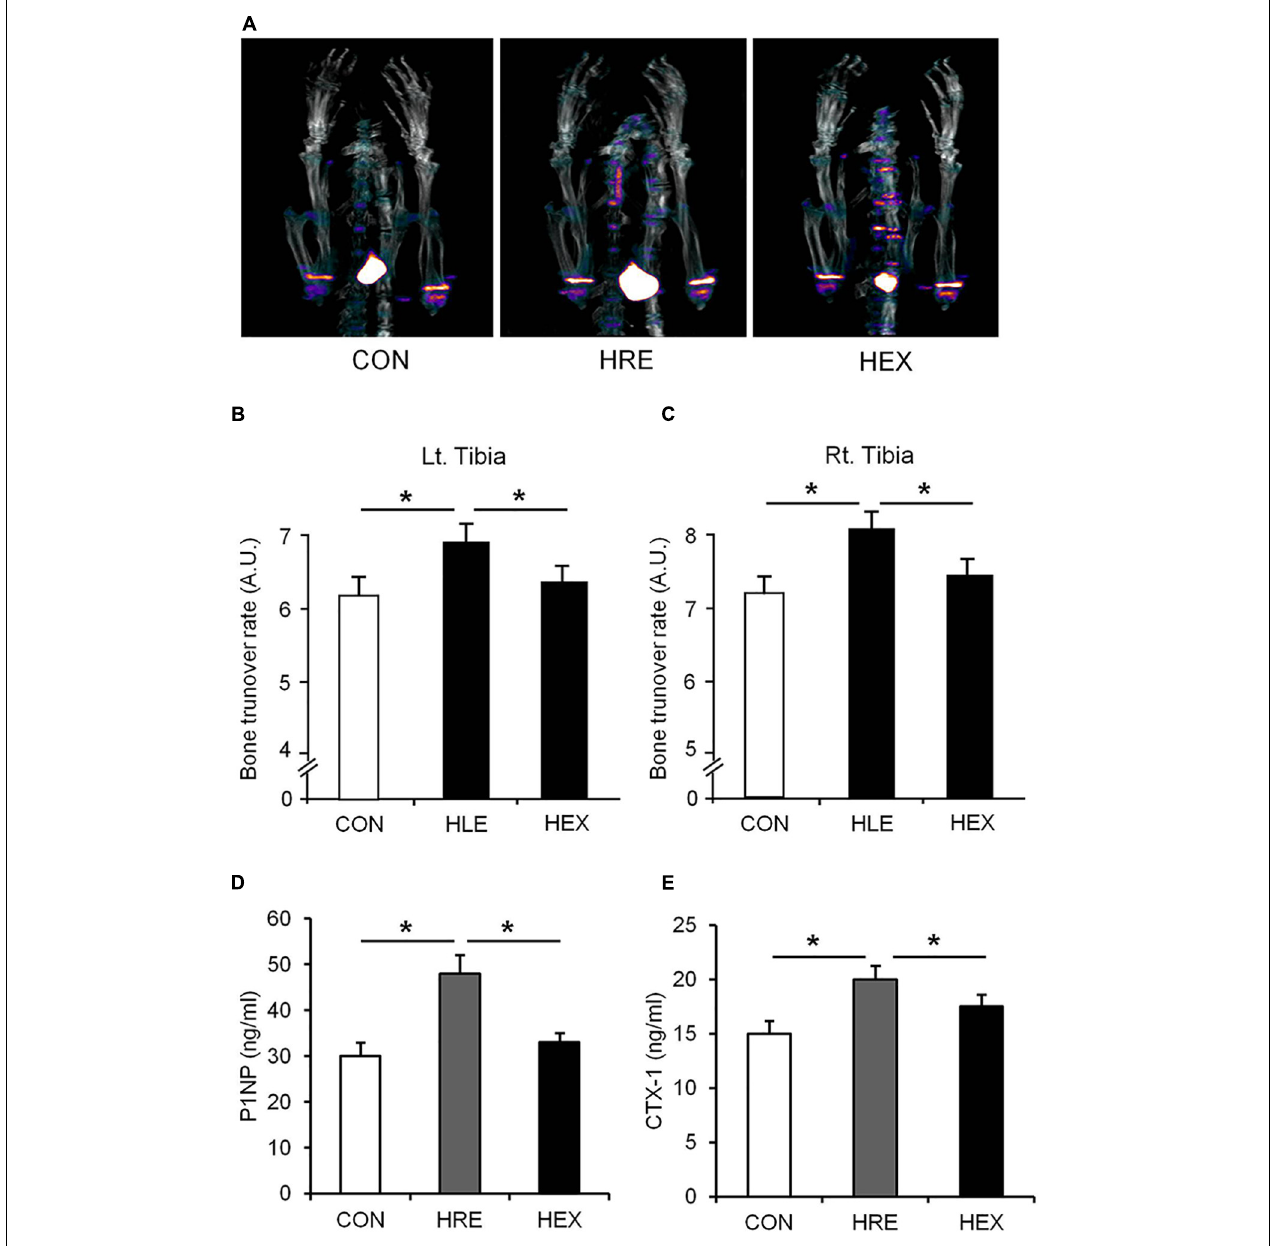
FIGURE 4 | The effects of re-ambulation and exercise on bone mineral metabolism following hindlimb suspension. (A) Representative PET/CT fusion images of tibia metaphysis. Bone turnover rate of (B) left and (C) right tibia was obtained from PET/CT fusion images. Biomarkers of (D) bone formation (P1NP) and (E) bone resorption (CTX-1) were measured by EIA analysis. ∗ p < 0.05. All the results were presented as mean ±